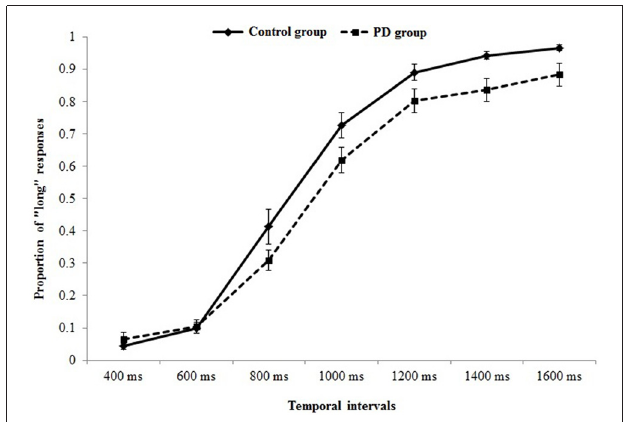
FIGURE 2 | Psychometric function indicating the probability of “long” responses, for each comparison interval in Parkinson’s disease (PD) participants and controls.